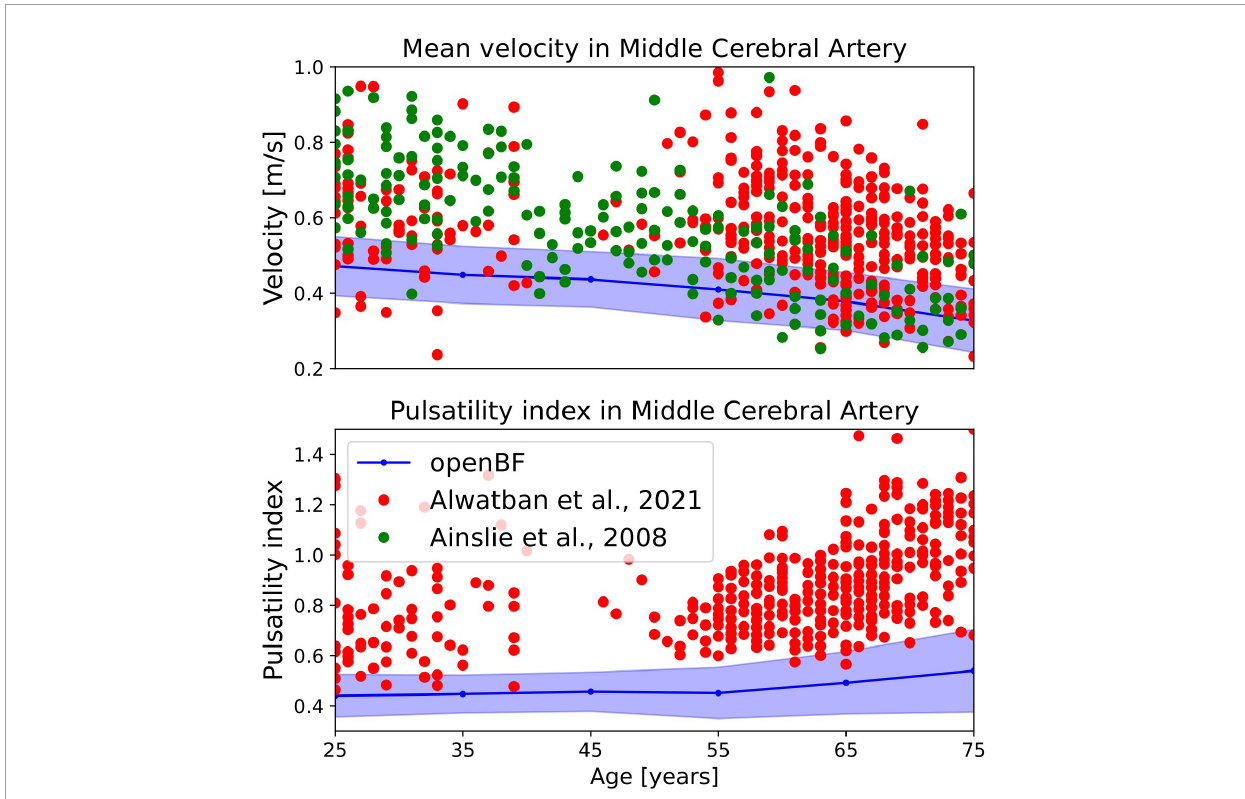
FIGURE5 Outcome of the ageing model, comparison of MCA mean velocity (top row) and pulsatility in the MCA (bottom row) against experimental data. Simulation results are shown in blue, validation points from Alwatban et al. (40) are shown in red, while points from Alwatban et al. (39) are shown in green.